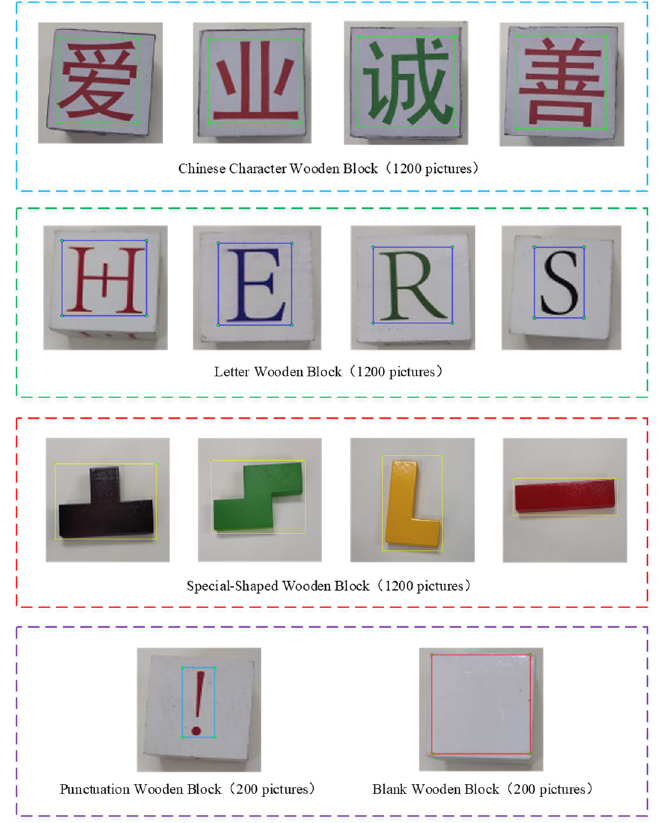
Figure 4. Wooden block image datasets.